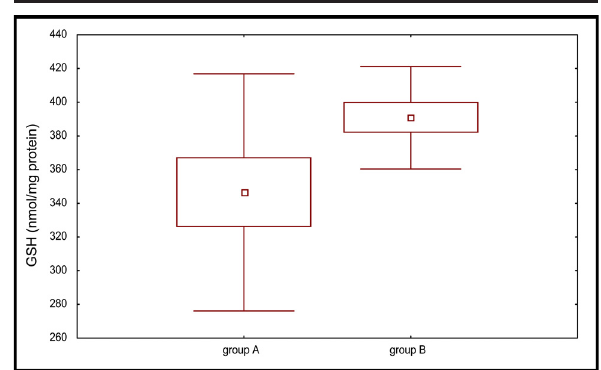
FIGURE 2 - Graphic presentation of the determination of hepatic mitochondrial glutathione (GSH in nmol/ mg protein) in the animals of group A (90 minutes of ischemia and 15 minutes of reperfusion) and group B (sham operation).